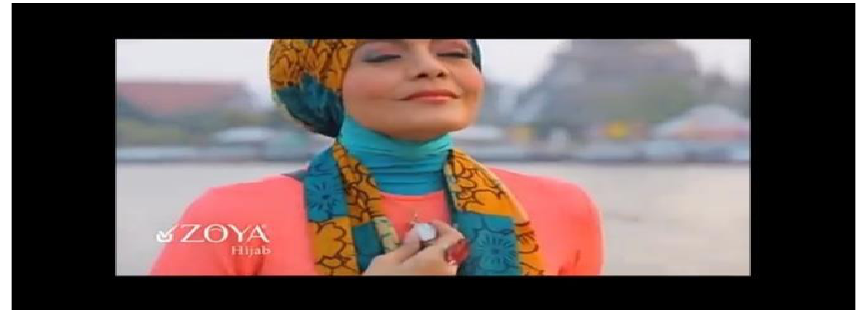
Figure 13: A Self-aware Muslim